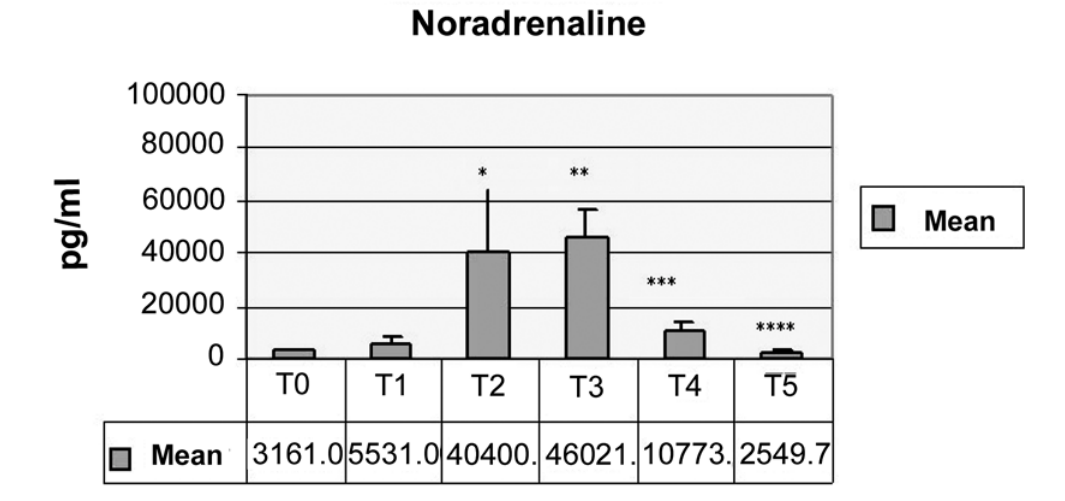
times.* Figure 1 – Mean serum noradrenaline concentrations at different surgical